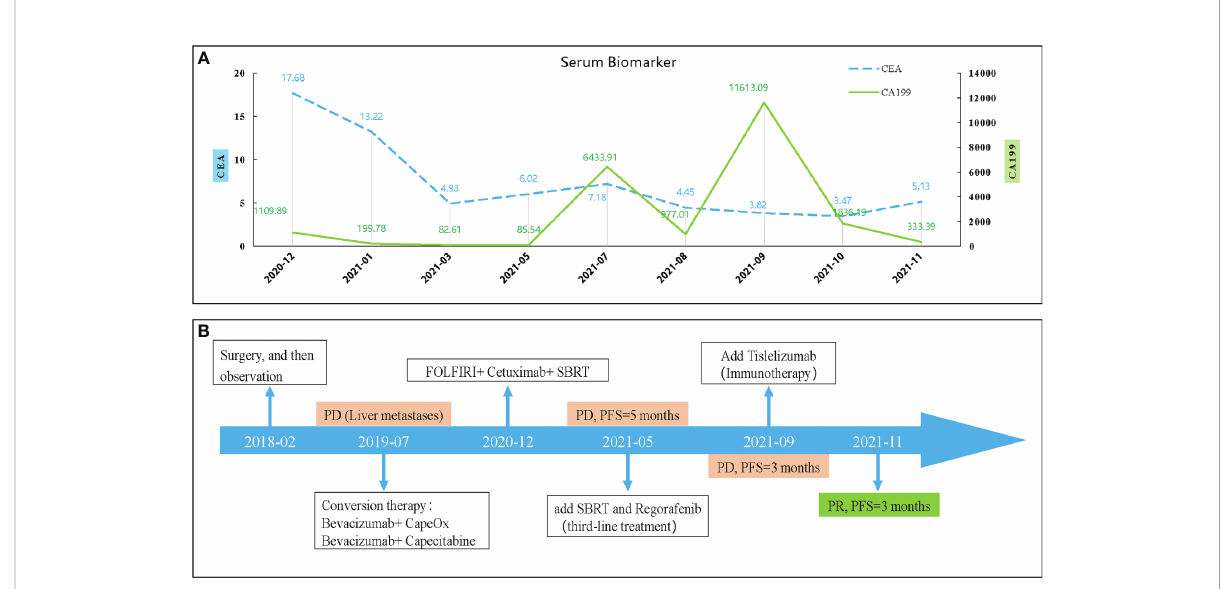
FIGURE 5 The change of serum biomarker (A) and timeline of treatment (B) . CEA, carcinoembryonic antigen; CA199, carbohydrate antigen 199; PD, disease progression; SBRT, stereotactic body radiation-therapy; PFS, progression-free survival.